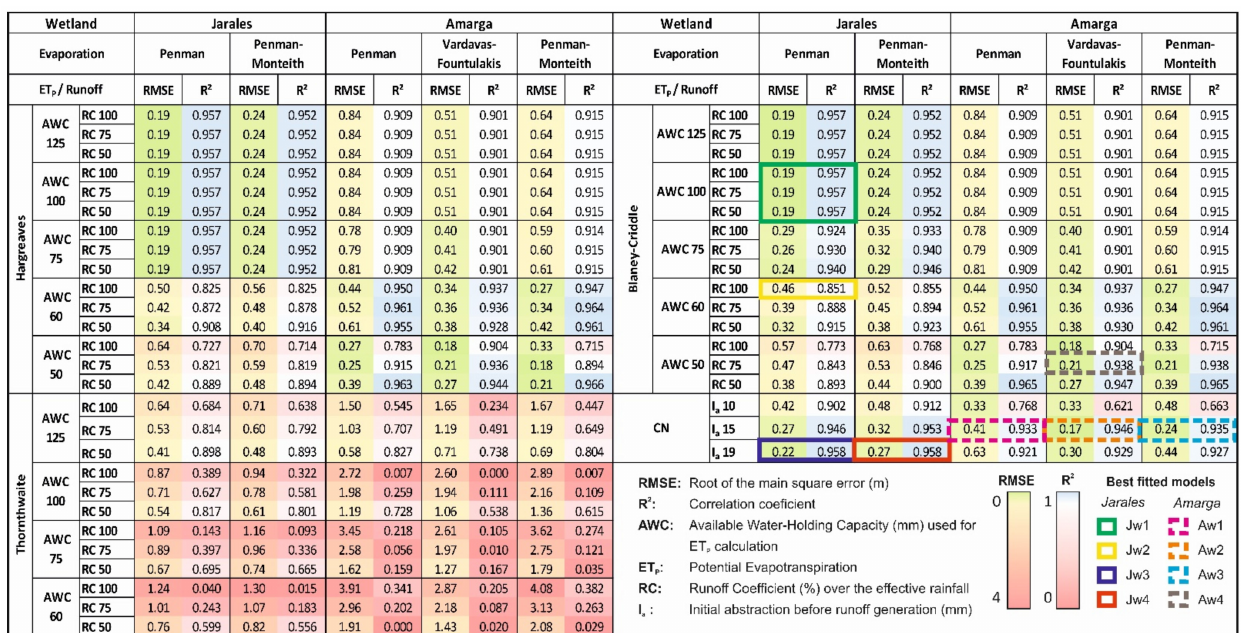
Figure 5. The root-mean-square error (RMSE) and the correlation coefficient ( R 2 ) of each limnimetric simulation computed in the Jarales and Amarga